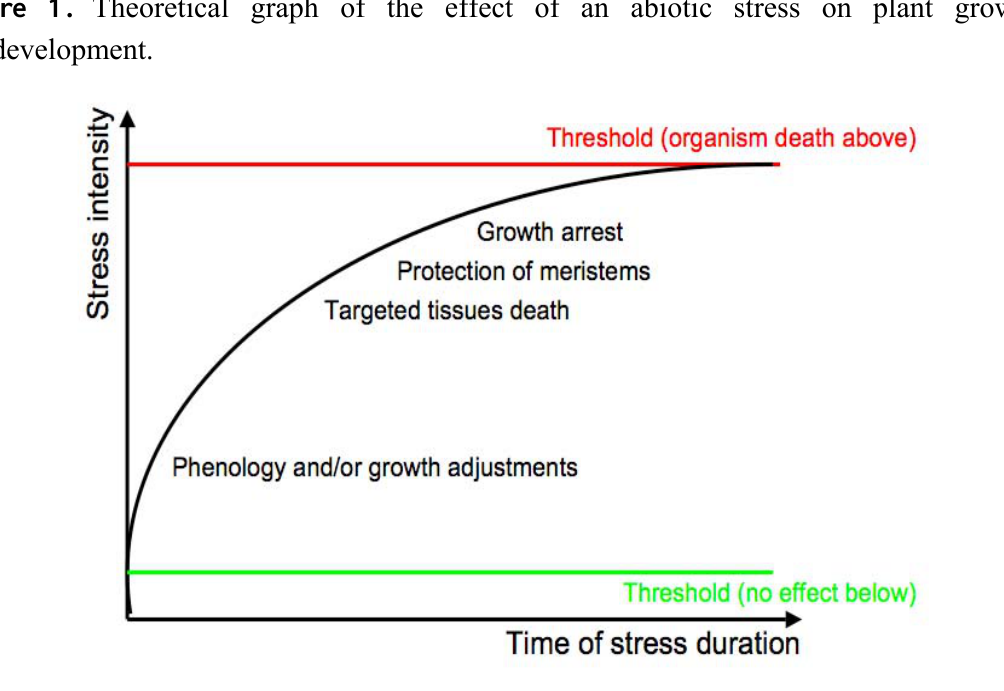
Figure 1. Theoretical graph of the effect of an abiotic stress on plant growth and